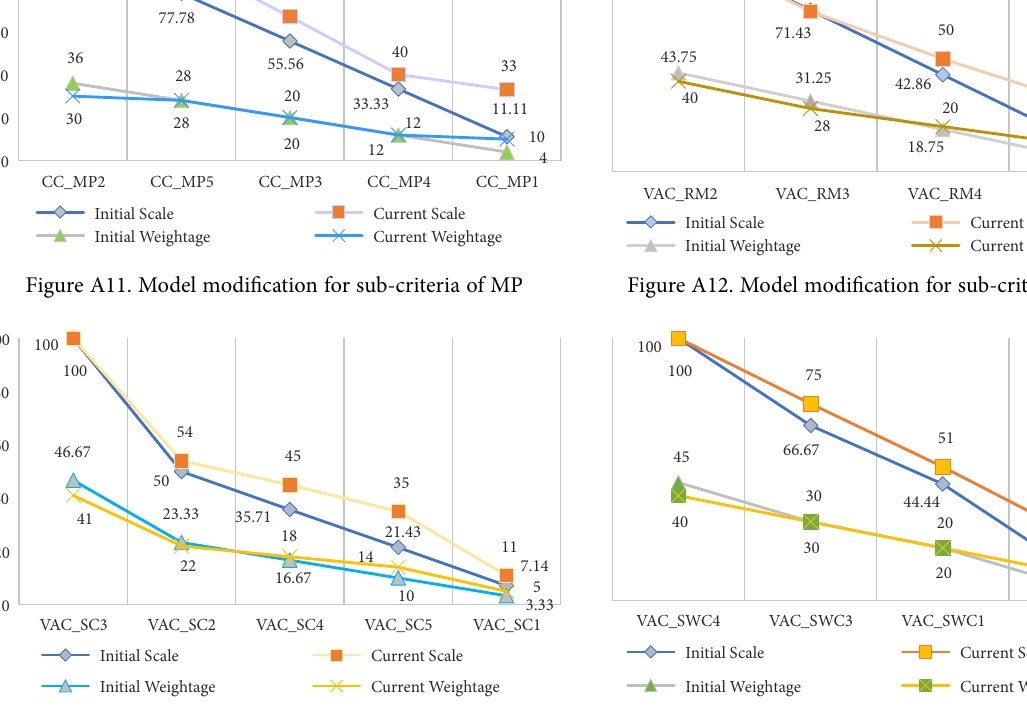
Figure A13. Model modification for sub-criteria of SC Figure A14. Model modification for sub-criteria of SWC